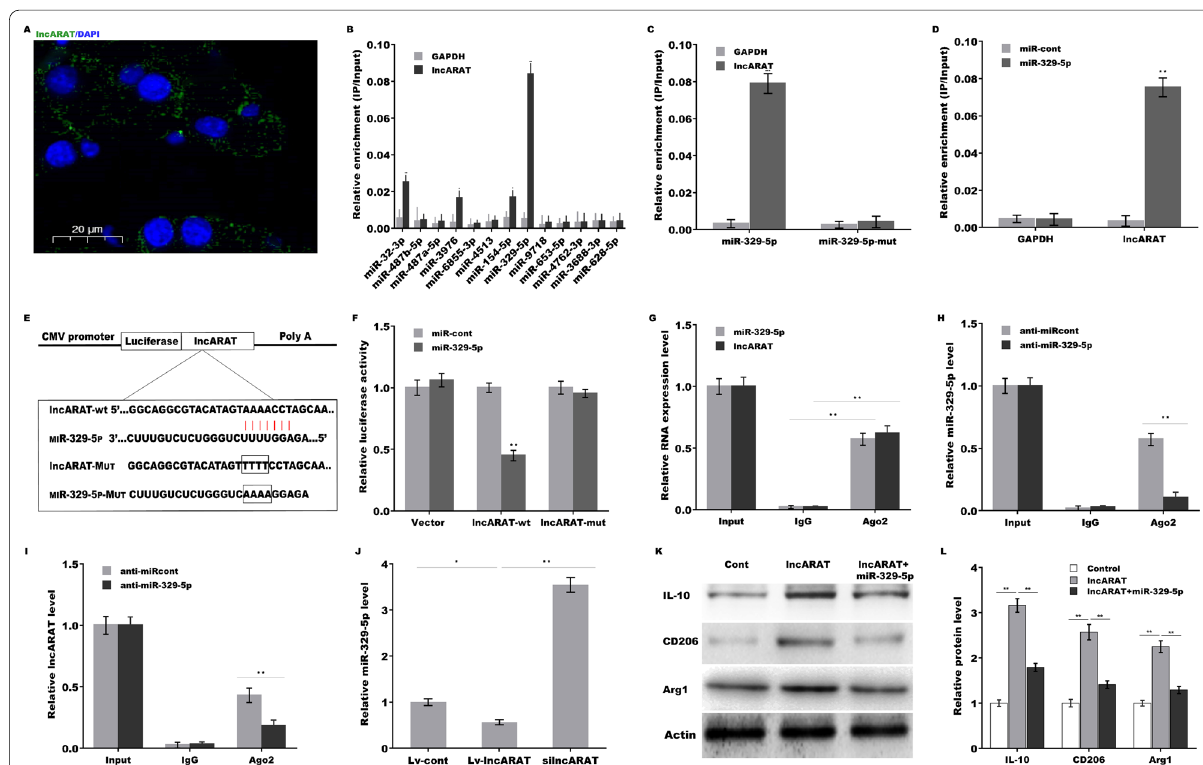
Fig. 5 LncARAT sponges miRNA-329-5p to induce macrophages activation into a proregenerative phenotype. A Subcellular localization analysis of lncARAT in U937 macrophages using RNA-FISH analysis. Scale bar, 20 µm. B Biotinylated miRNAs were transfected into U937 macrophages, and then an RNA pull-down assay was performed to assess the interaction of lncARAT with specific miRNAs. C Biotinylated miRNA-329-5p mutants were transfected into U937 macrophages, and then an RNA pull-down assay was performed. D Biotinylated lncARAT was transfected into U937 macrophages, and then an RNA pull-down assay was performed to assess miR-329-5p enrichment. E Schematic representation of the miRNA-329-5p site in lncARAT. F Luciferase activity was assayed in HEK293 cells after cotransfection with miRNA-329-5p and luciferase reporters containing lncARAT. G RIP assays with anti-Ago2 antibody were performed to assess the enrichment of lncARAT and miRNA-329-5p in U937 macrophages. RIP assays with anti-Ago2 antibody were performed to assess the enrichment of miRNA-329-5p ( H ) and lncARAT ( I ) in response to miRNA-329-5p inhibition. J qRT-PCR analysis of miRNA-329-5p expression in U937 macrophages after lncARAT overexpression or knockdown. Western blot ( K ) and quantitative analysis of L IL-10, CD206, and Arg1 expression in U937 macrophages after Lv-lncARAT overexpression in the presence or absence of miRNA-329-5p. * p < 0.05. ** p <